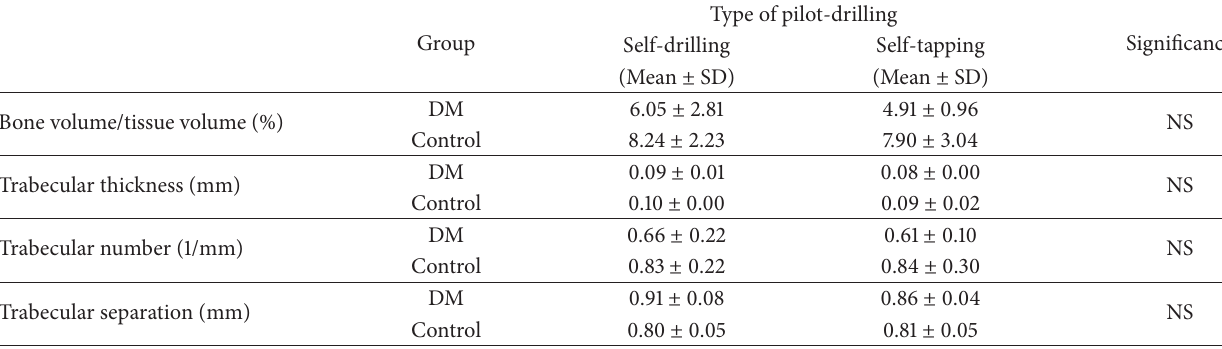
Table 4: Three-dimensional bone microstructure analysis in bone marrow area. Type of pilot-drilling Group